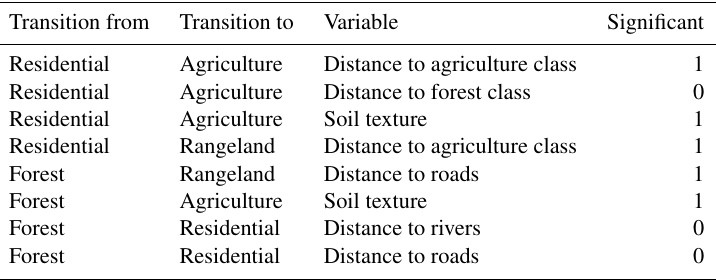
Table 1. Summary of final effective variables.